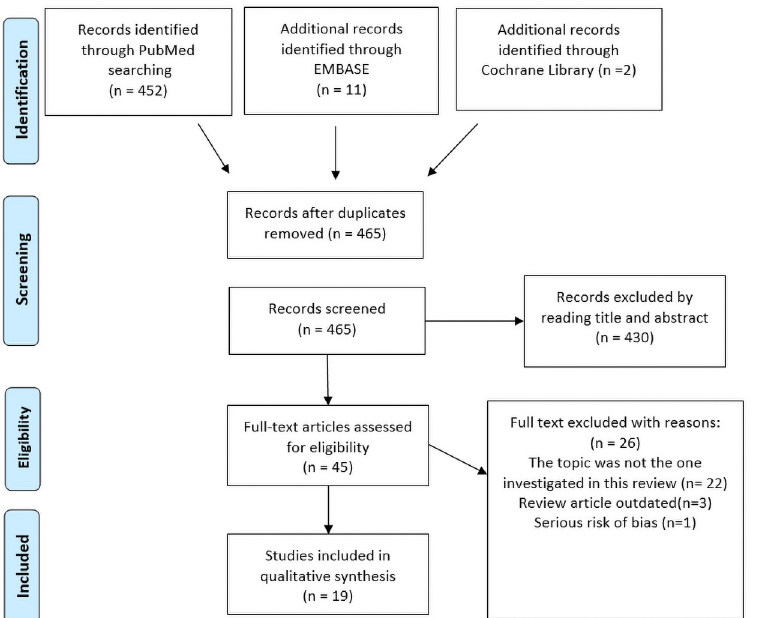
Fig 1. A PRISMA flowchart showing the selection